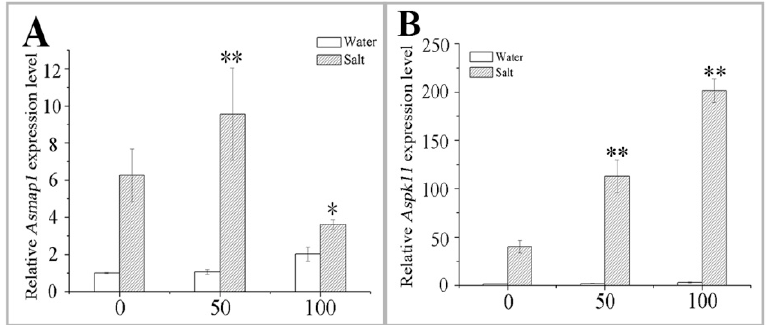
Figure 8. Effect of pretreating with different concentrations of melatonin (MT) on the expression of MAPK in leaves of naked oat seedlings under salt stress. The relative expression of MAPK genes Asmap1 ( A ) and Aspk11 ( B ). Values are mean ± standard deviation ( n = 3). 0, 50, and 100 represent MT concentration ( µ M) in Figure 8. Asterisks; * and ** indicate significant difference ( p < 0.05 and p < 0.01) compared with mock coating (0 µ M). Measurement was carried out after six days of the salt plus MT pretreatmemt.